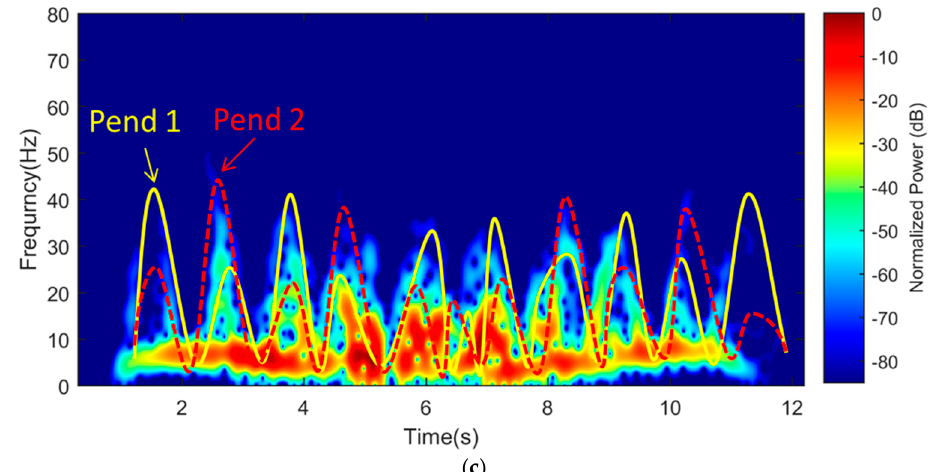
Figure 21. Spectrogram for two pendulums opposite to each other with release angles, θ 0 at: ( a ) 20 ◦ ; ( b ) 40 ◦ ; and ( c ) 70 ◦